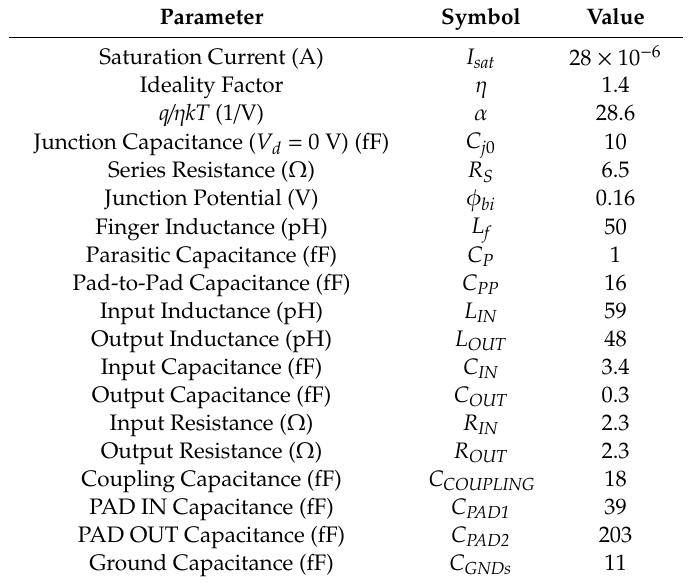
Table 4. Results of the parameter extraction of the total capacitance of ZBD.